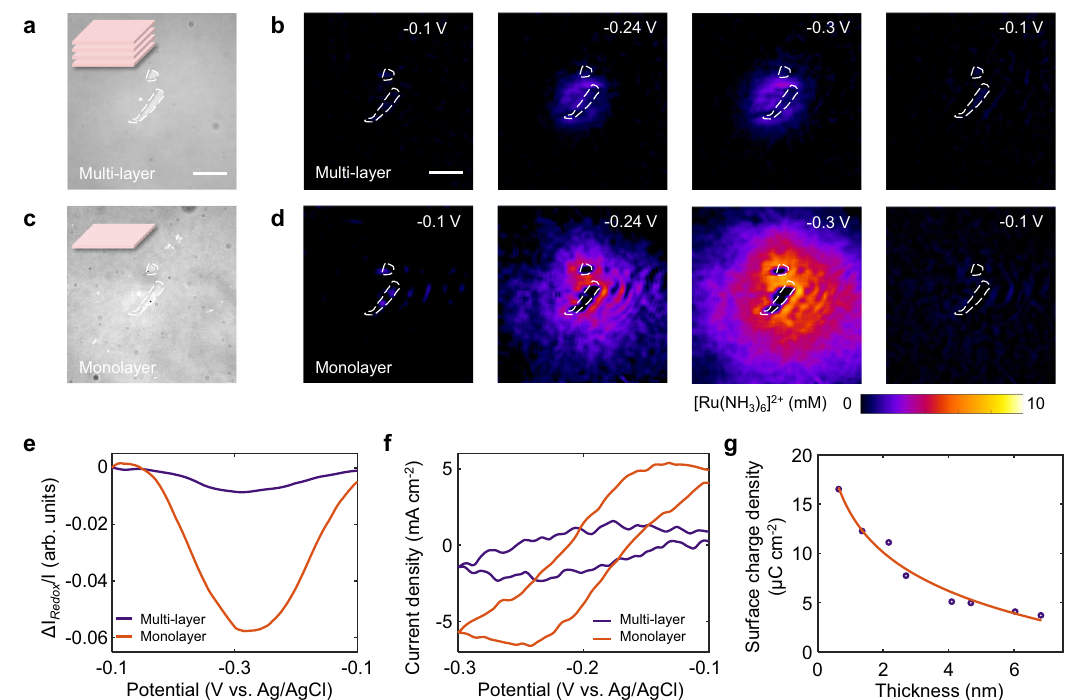
Fig. 4 | Layer-dependent electrocatalytic activity of single MoS 2 nanosheets. Optical images and snapshots of plasmonic images of ( a , b ) multilayer MoS 2 and ( c , d ) the corresponding surface plasmon-thinned monolayer MoS 2 during poten- tial sweeping, illustrating the signi fi cant difference in the concentration of [Ru(NH 3 ) 6 ] 2+ ions. The scale bar represents 20 μ m. e Plasmonic intensity change